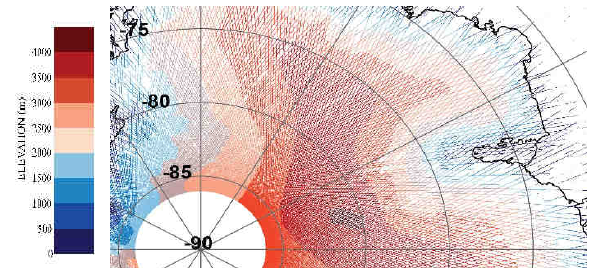
Figure 1. Visualization of tracks of ICESat/GLAS data during a campaign (9 th March-11 April, 2009) over East Antarctica.